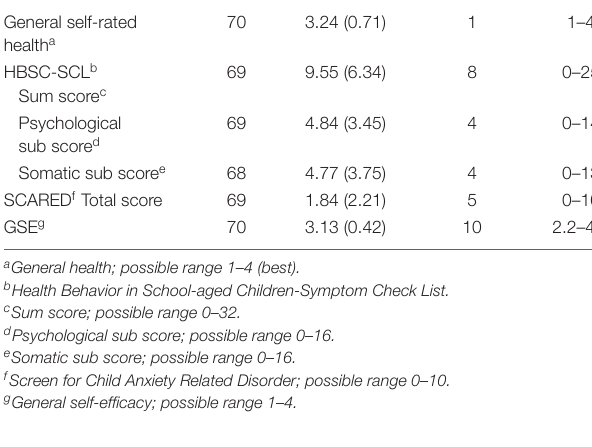
TABLE 3 | Self-reported asthma characteristics, by EILO subgroups a .